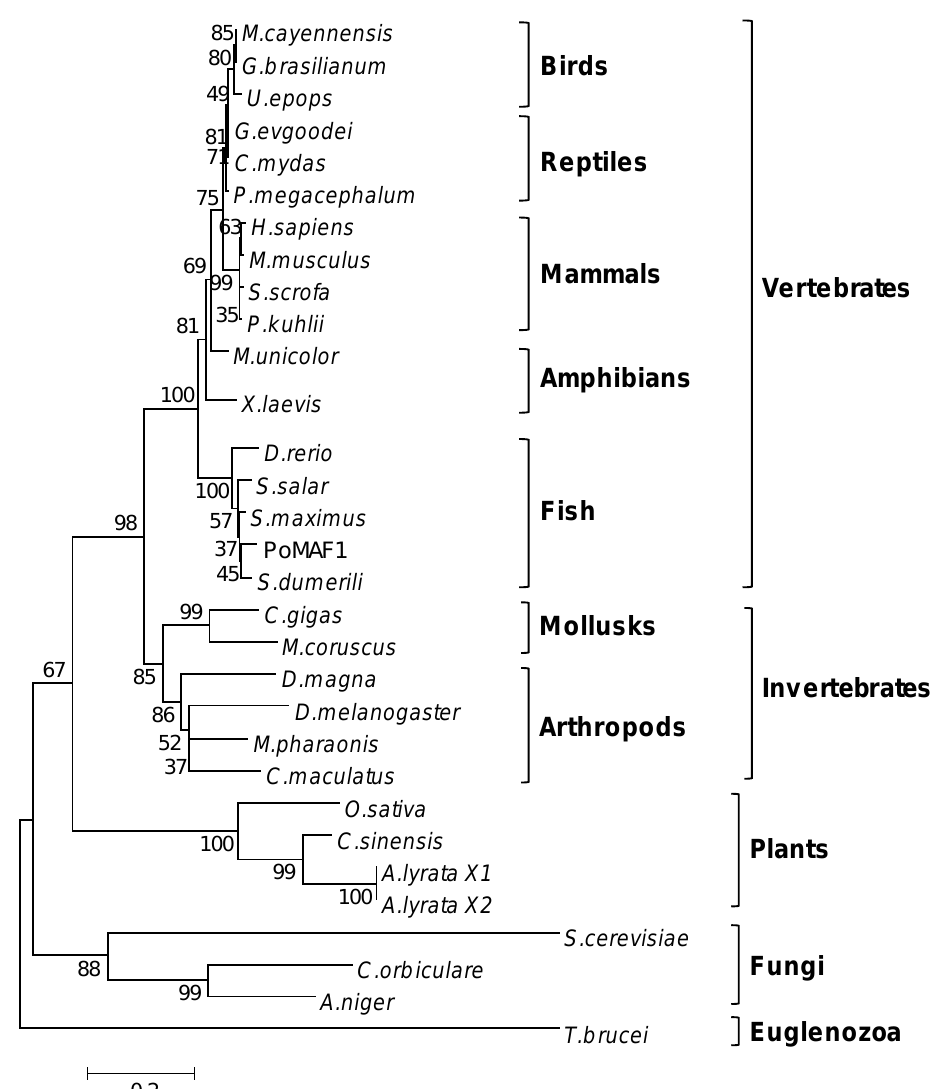
Figure 3. Phylogenetic relationship of PoMAF1 with its orthologues. The tree is based on alignment of the amino acid sequences from vertebrates—birds, reptiles, mammals, amphibians and fish—and invertebrates, and shows that PoMAF1 clusters with MAF1s from fish species. Bootstrap values are shown as percentages at the nodes. GenBank accession numbers of PoMAF1 orthologues are provided in Table 1. Table 1. GenBank accession numbers used for phylogenetic tree construction.